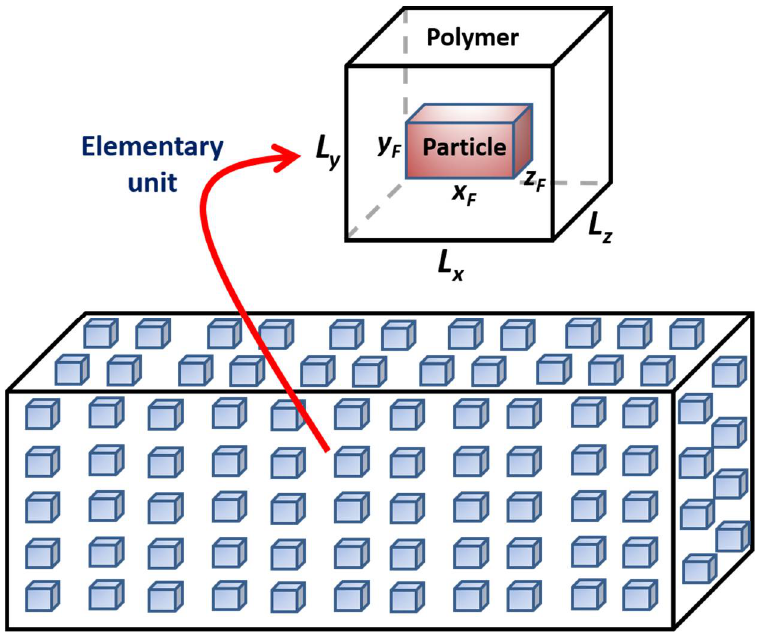
Figure 1. Schematic diagram of a section of an MMM consisting of a myriad of identical elementary units, each comprised of a centrally located filler particle embedded in the polymer matrix.